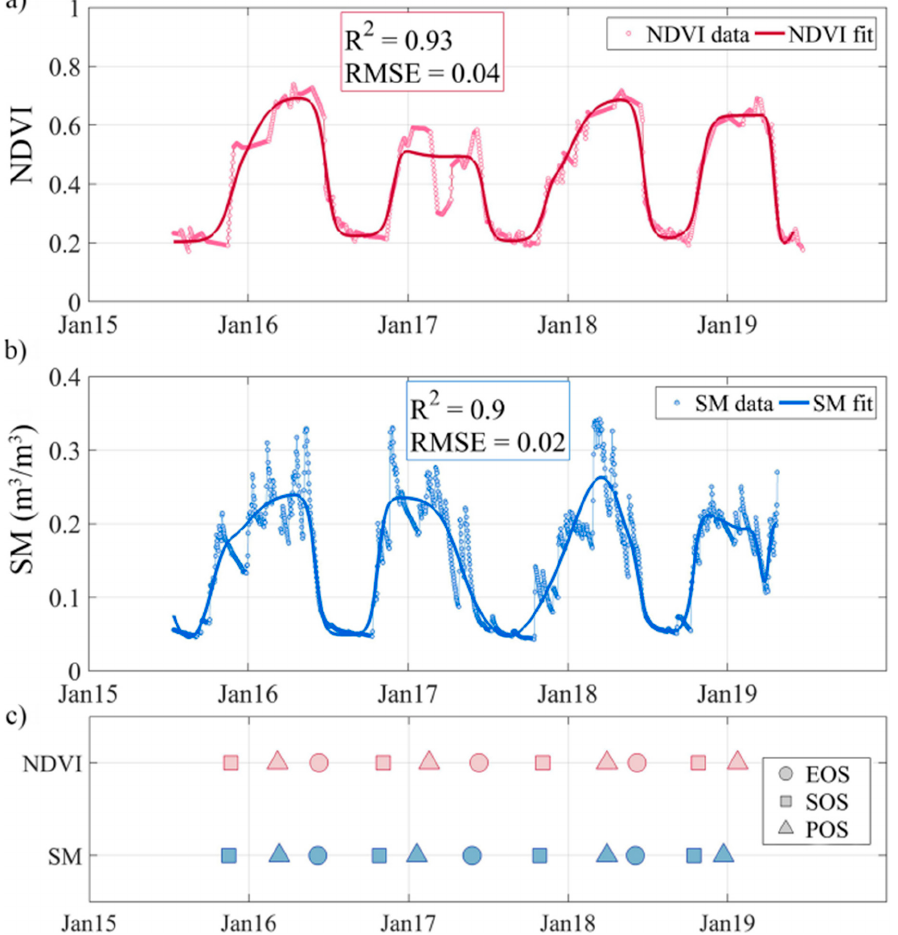
Figure 9. ( a ) Evolution of NDVI (raw data, fitted function and error) throughout the study period. ( b ) Evolution of SM (raw data, fitted function and error) during the study period. ( c ) Comparison of the phenological dates of NDVI and SM in the whole study period